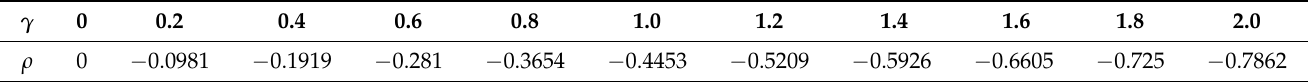
Table 7. Numerical values for ρ with α = γ /2 and γ ∈ { 0,0.2, . . . ,1.8,2 }